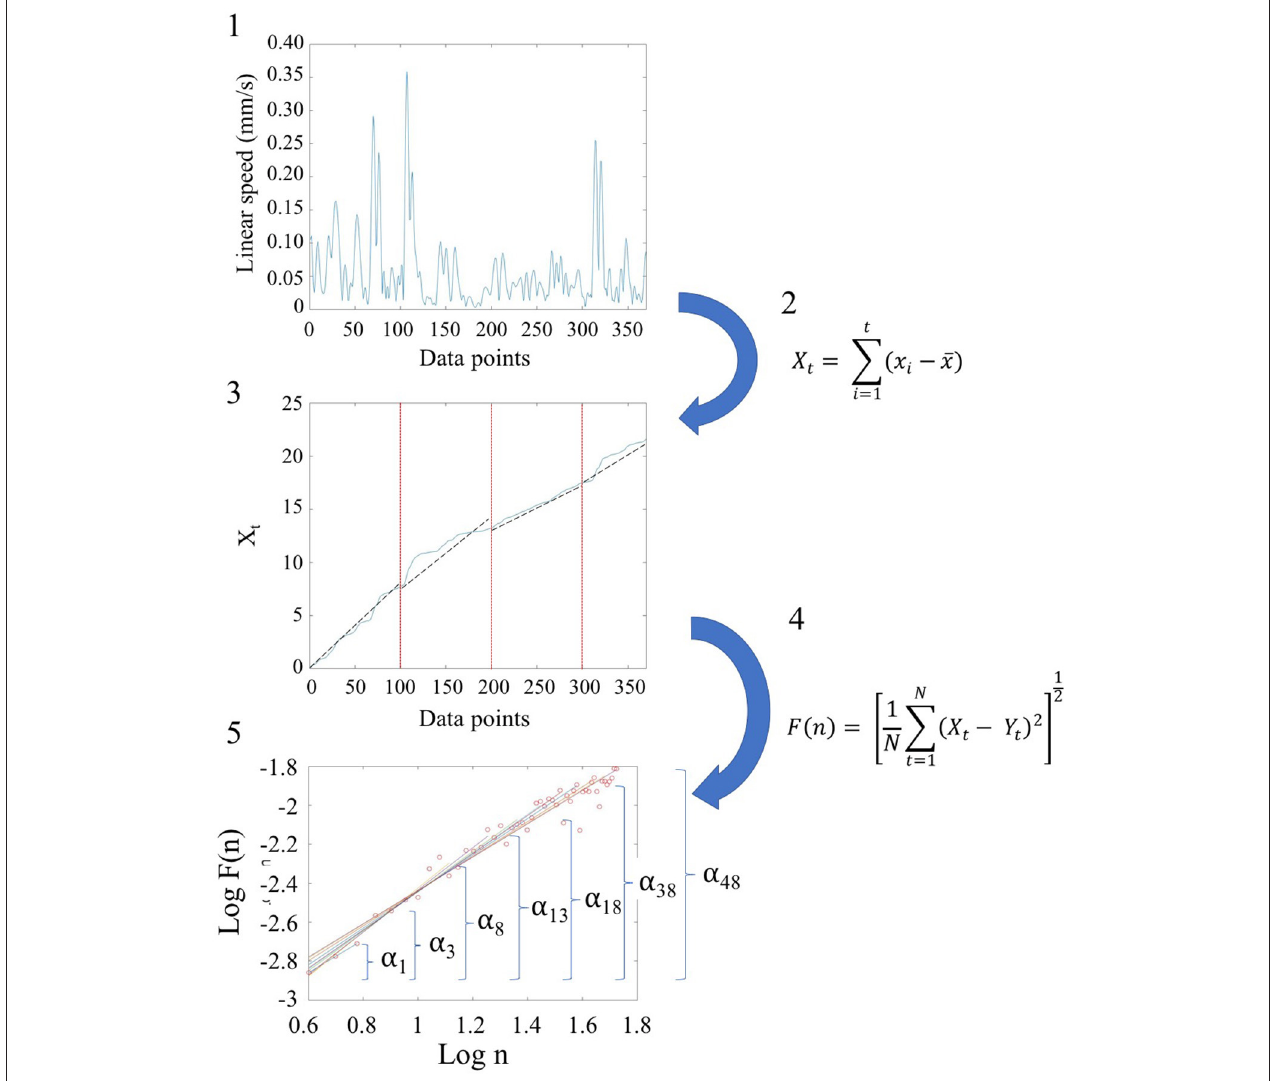
FIGURE 2 | Schematic steps to perform the Detrended Fluctuation Analysis (DFA) using the linear and angular speed profiles of the involuntary hear excursions. (Step 1) Sample raw linear speed data extracted from linear positional displacements of the head along the x-, y-, and z-axis. The magnitude of the rate of displacements frame by frame (the linear speed temporal profile) is obtained and the profile resampled at 2Hz. The data is truncated to 370 points for all participants to ensure equal number of points (see Figure S1); (Step 2) Given the time series of length N = 370, (the minimum number of points across the data set) we obtain the integration or t x i − h x i where t denotes the size of the window, x i is each point in the series within the window and h x i is the summation within 100-point window for each X t = i = 1 (cid:0) (cid:1) P overall mean across the entire time series with linear speed (empirical range bounded between 4.28e-05 and 10.14 mm/s over the entire data set.) The X t is the cumulative sum or profile and the summation converts from a bounded time series to unbounded process. (Step 3) The cumulative profile X t is divided into non-overlapping time windows of equal length n (range 4 ≤ n ≤ N /10) where N is the total number of points in the signal, which in our case is N = 370 (Chen et al., 2002). In each interval, a local least-squares straight-line fit (which is the local trend) is obtained using minimization of the least squares errors in each window. The resulting piecewise sequence of straight line fits is denoted Y t , then we calculate the root-mean-square deviation from the trend, i.e., the fluctuation: N 1 F ( n ) = ( X t − Y t ) 2 . (Step 4) The above process of detrending and obtaining the fluctuation metric is repeated over a range of different window sizes and a N s t = 1 P log-log map of n vs. F( n ) obtained. This map provides a relationship between F(n) , the average fluctuation as a function of box size, and the box size n . As explained in (Peng et al., 1995a), the straight line of this log-log relation indicates statistical self-affinity expressed by the scaling exponent alpha, F ( n ) ∝ n α . The exponent alpha (a generalization of the Hurst exponent Hurst, 1951, is a measure of long time memory in a time series) is the slope of the straight line fit to the log( n ) vs. log (F(n)) relation using least squares. (Step 5) To obtain a series of alpha values for each participant, we windowed the data starting with 3 points, then 4 points, then 5 points, etc. to the maximum number of points (370) we